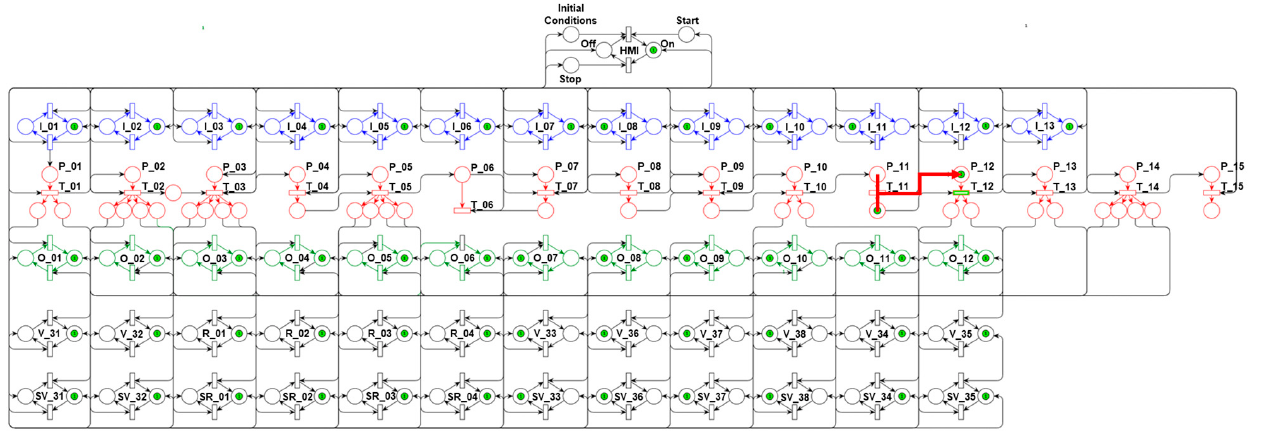
Figure 32. Algorithm’s 13th step—Timer.